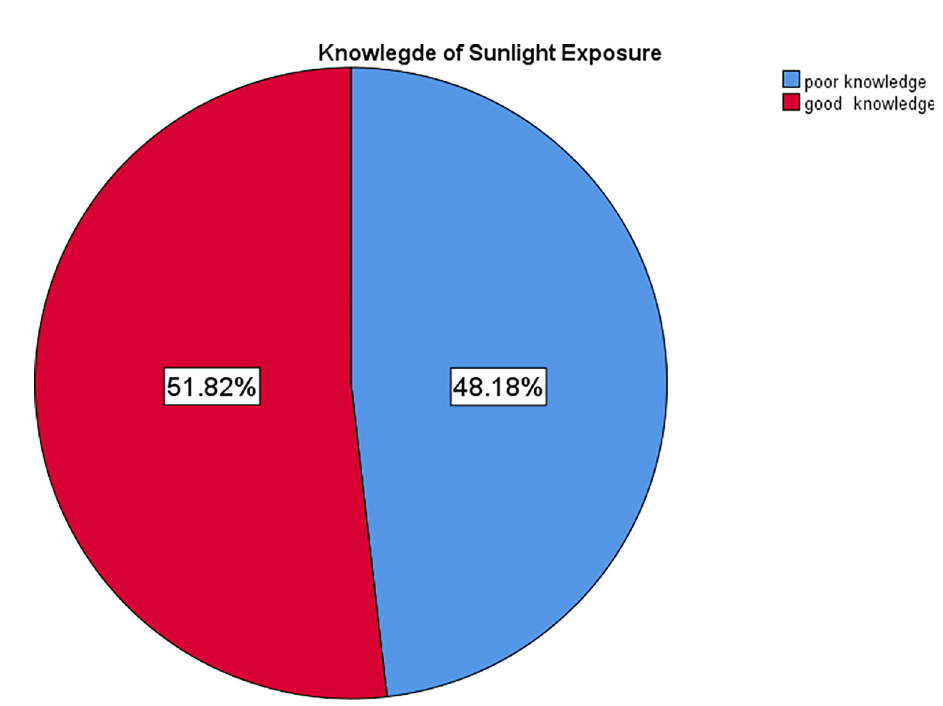
Fig 1. Knowledge of infants’ sunlight exposure among mothers attending EPI unit at WUSH,